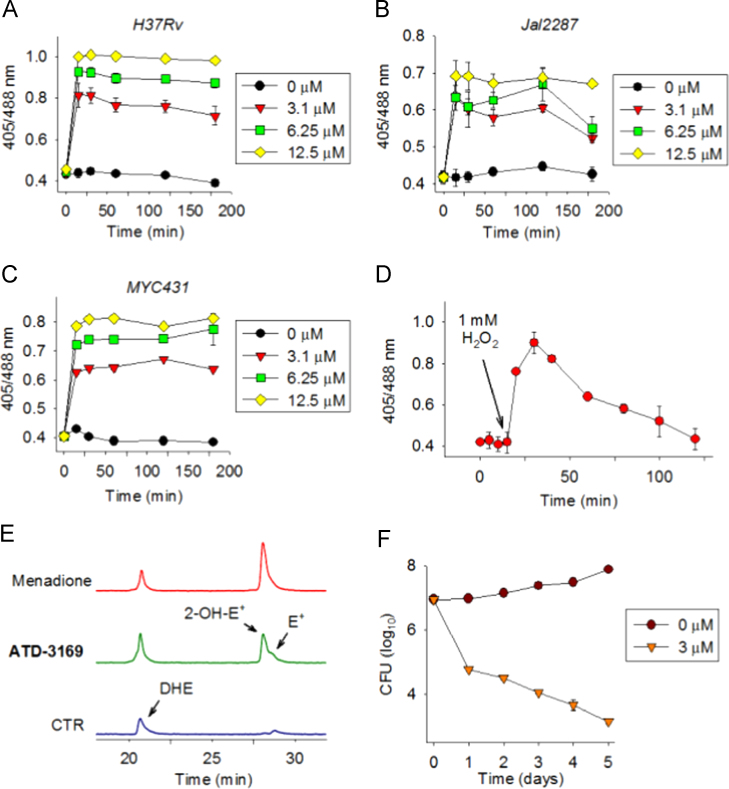
ATD-3169 induces a long-lasting oxidative shift in EMSH of Mtb strains. Mtb strains (A) H37Rv, (B) Jal 2287, and (C) MYC 431 expressing Mrx1–roGFP2 were treated with ATD-3169 at various concentrations and the sensor response was measured by flow cytometry at various time points. Data shown are representative of at least three different experiments performed in triplicate. (D) H37Rv expressing Mrx1–roGFP2 was treated with 1 mM H2O2 and the sensor response was measured by flow cytometry as a function of time. Data shown are representative of at least two different experiments performed in triplicate. Error bars represent standard deviations from the mean. (E) HPLC traces of assay for intracellular O2−• production using a dihydroethidine (DHE) assay in BCG. Incubation with compounds (50 µM) was for 30 min and DHE levels indicate unoxidized dye while 2-OH-E+ formed is an indicator for O2−• production and E+ is indicative of an increase in oxidative species. Menadione is a known redox-cycling agent that enhances ROS and was used as a positive control. (F) H37Rv was grown to an OD600 nm of 0.6, diluted to an OD600 nm of 0.06, and treated with 3.1 μM ATD-3169 compound. At the indicated time points, CFUs were determined by plating cultures on 7H11 solid media supplemented with ADS. *P<0.05 as compared to untreated control day 0,+P <0.05 as compared to untreated control day 5.